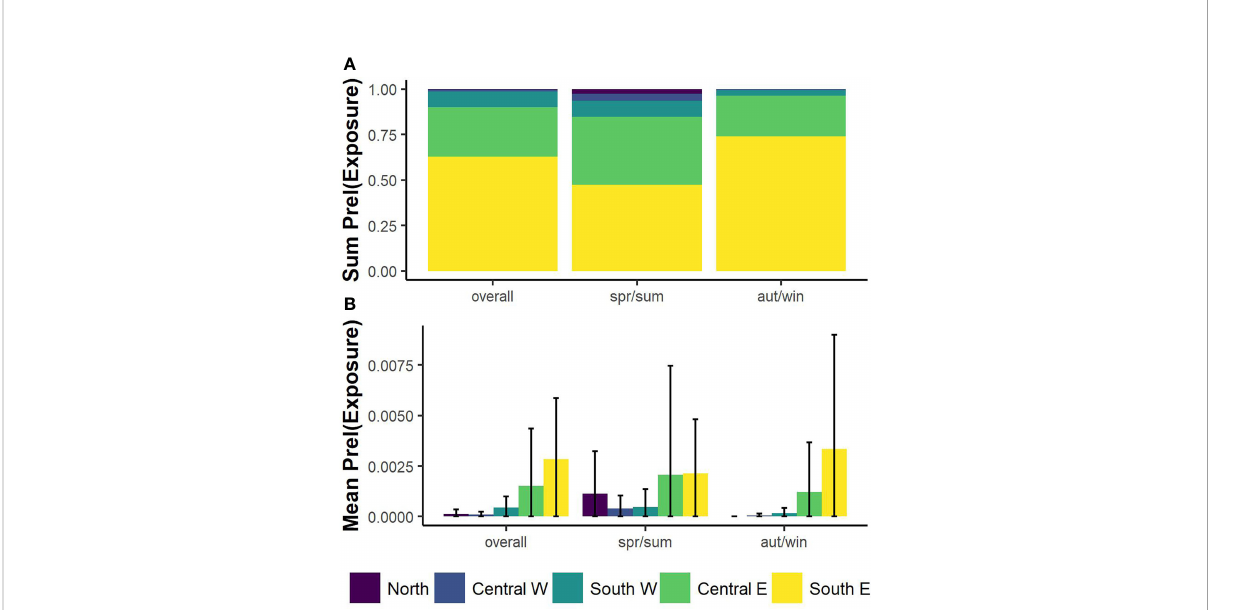
FIGURE 4 Bar plots of summed values (A) and mean values with error bars (B) of relative probabilities of vessel-turtle co-occurrences (prel(Exposure)) according to TYS subareas; N-TYS, northern Tyrrhenian Sea; CW-TYS, central-western Tyrrhenian Sea; CE-TYS, central eastern Tyrrhenian Sea; SW-TYS, southwestern Tyrrhenian Sea; SE-TYS, south Eastern Tyrrhenian